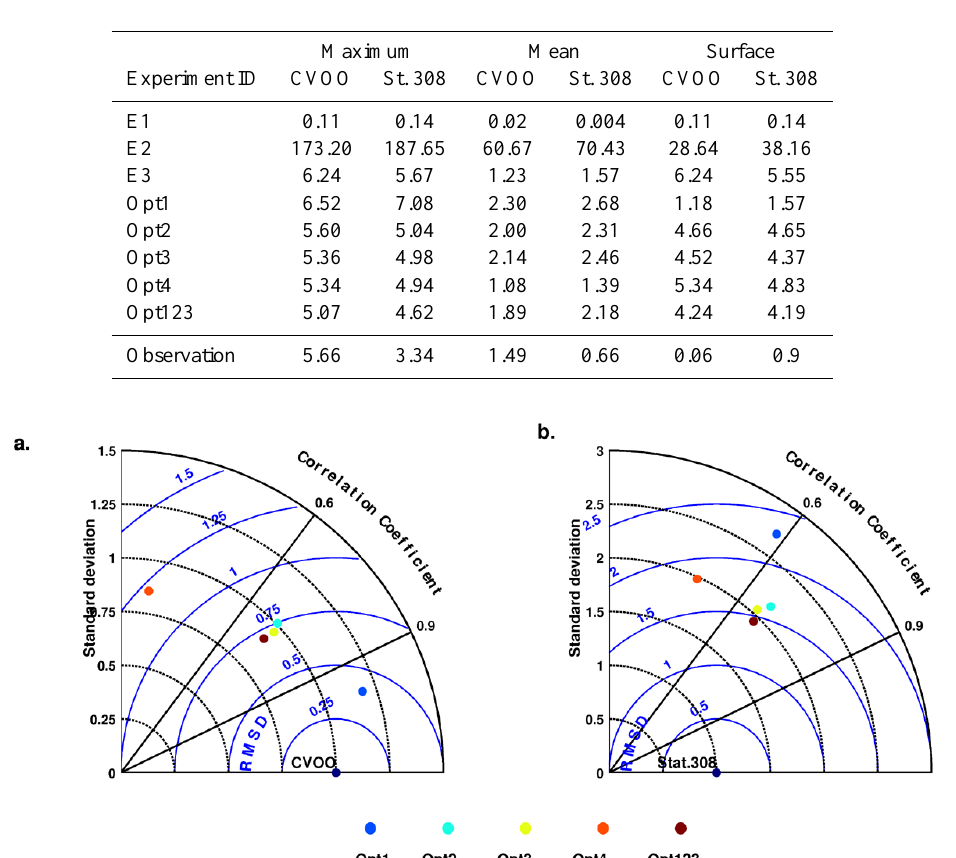
Table 3. Observed and modelled concentrations at the surface, concentration minima, and maxima [pmolL − 1 ]. Modelled values are means of the respective months at the depth of the observations.